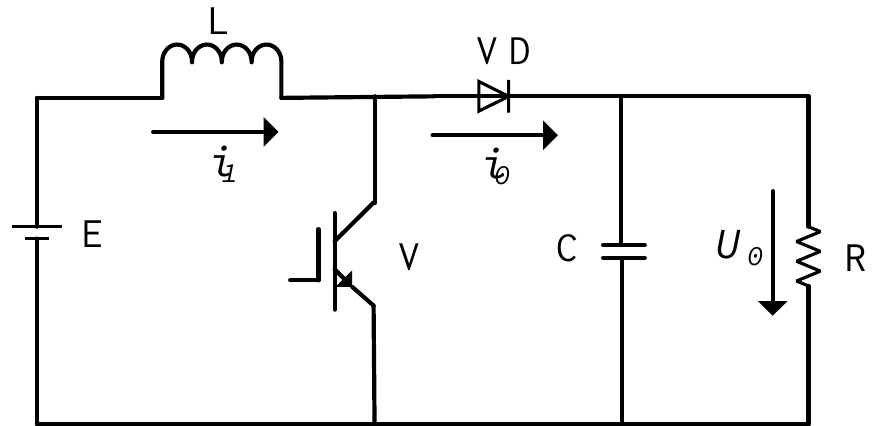
Figure 4. Boost circuit diagram.